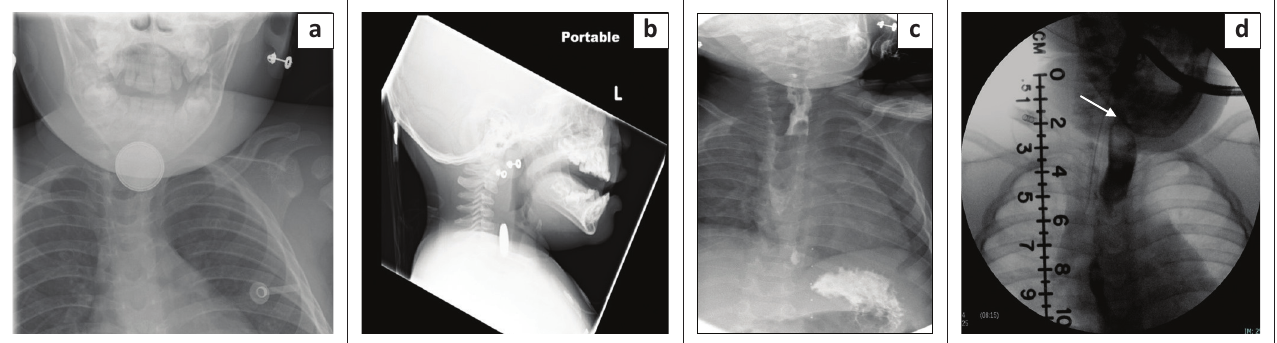
FIGURE 6: Frontal (a) and lateral (b) radiographs of the neck reveal a button battery in the cervical oesophagus. An initial radiograph (c) carried out 3 days post ingestion shows mild irregularity at the site of the button battery impaction, but no contrast extravasation was observed. Follow-up fluoroscopy (d) performed 3 months later demonstrates a stricture (arrow) involving the cricopharyngeal portion.